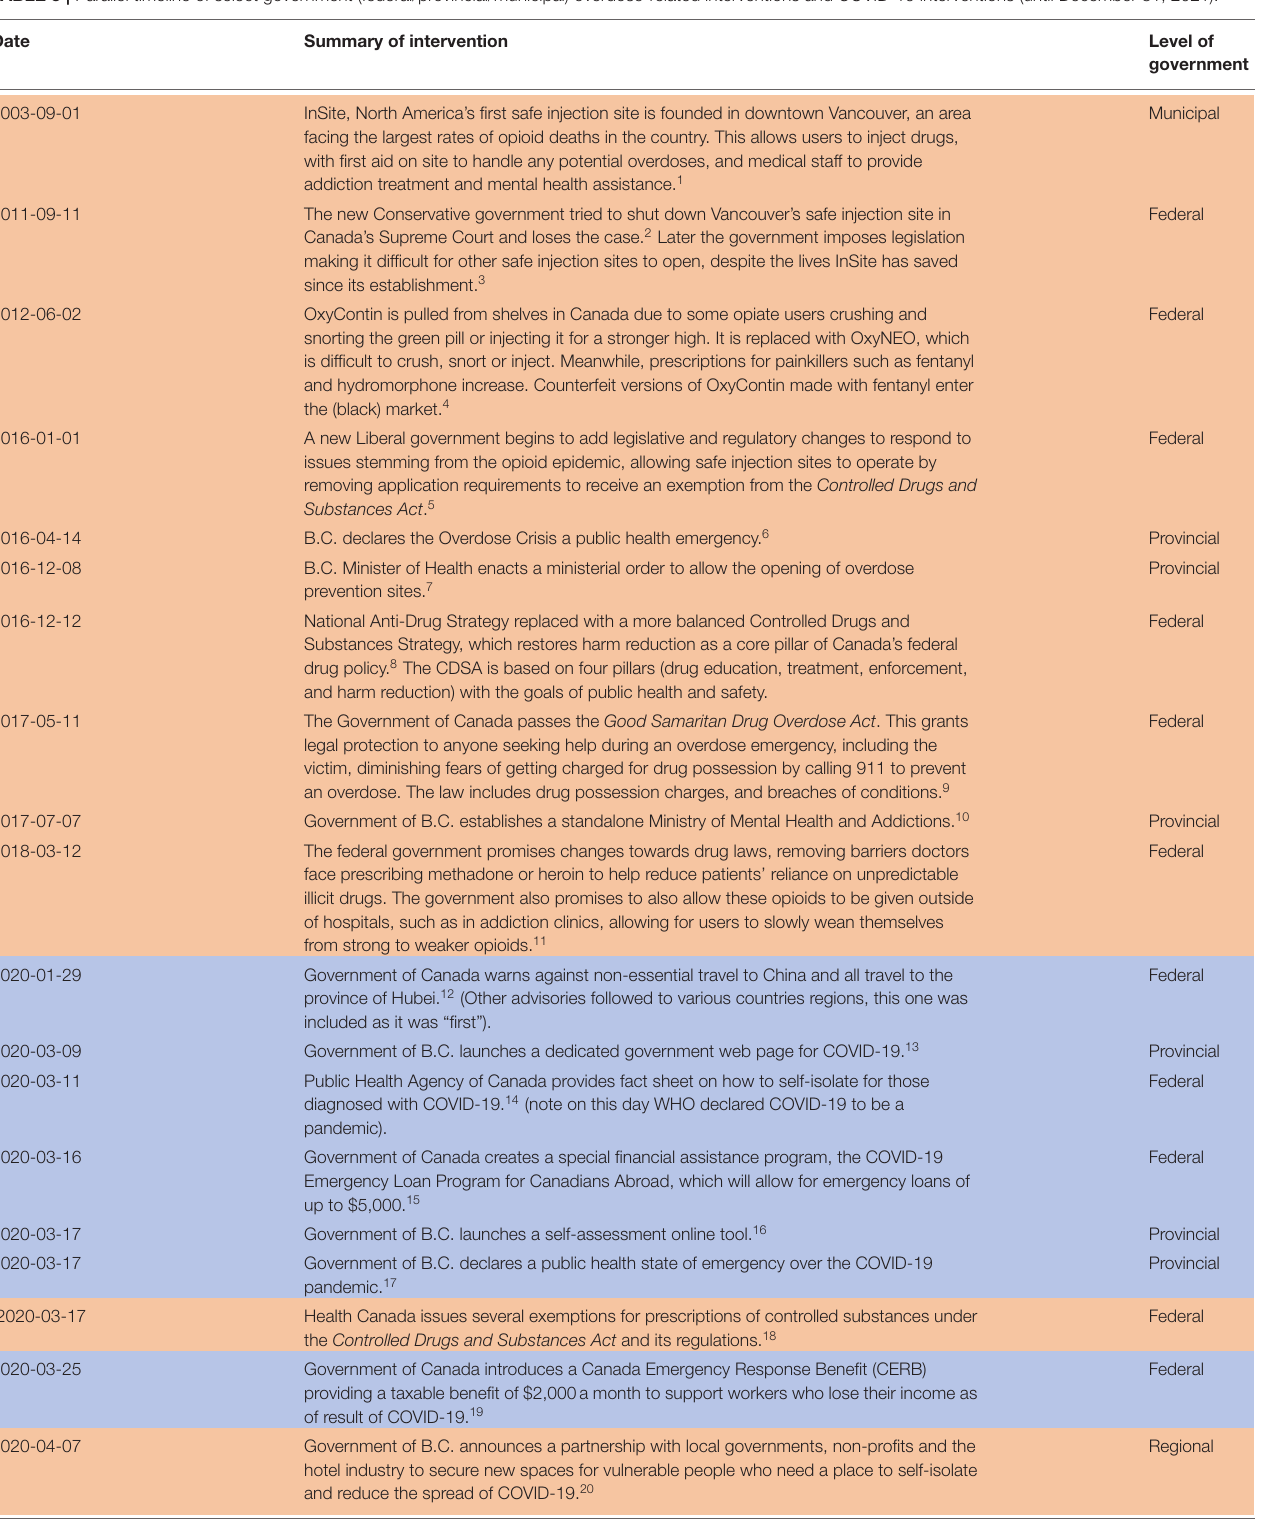
TABLE 3 | Parallel timeline of select government (federal/provincial/municipal) overdose-related interventions and COVID-19 interventions (until December 31,